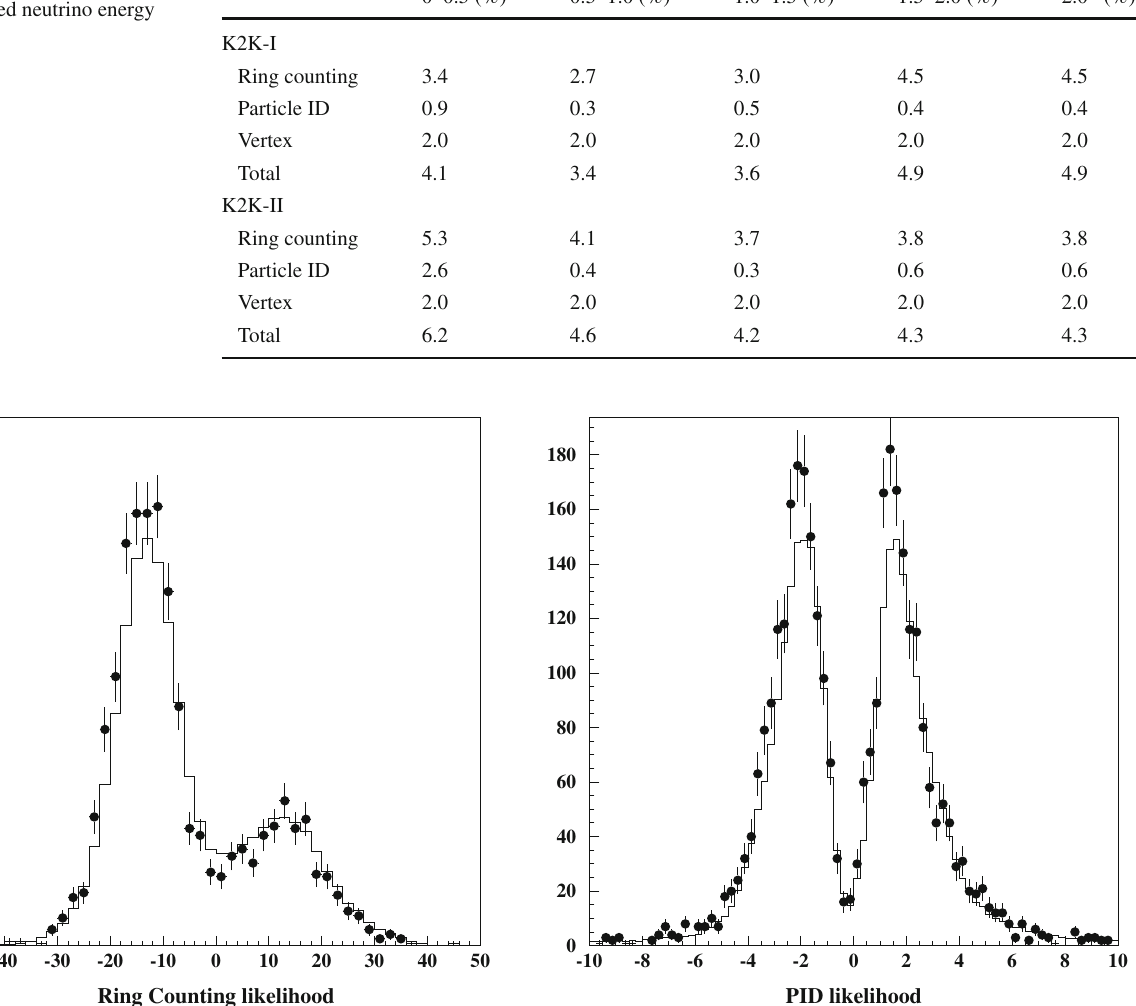
Table 9 Systematic errors for reconstructed neutrino energy spectrum